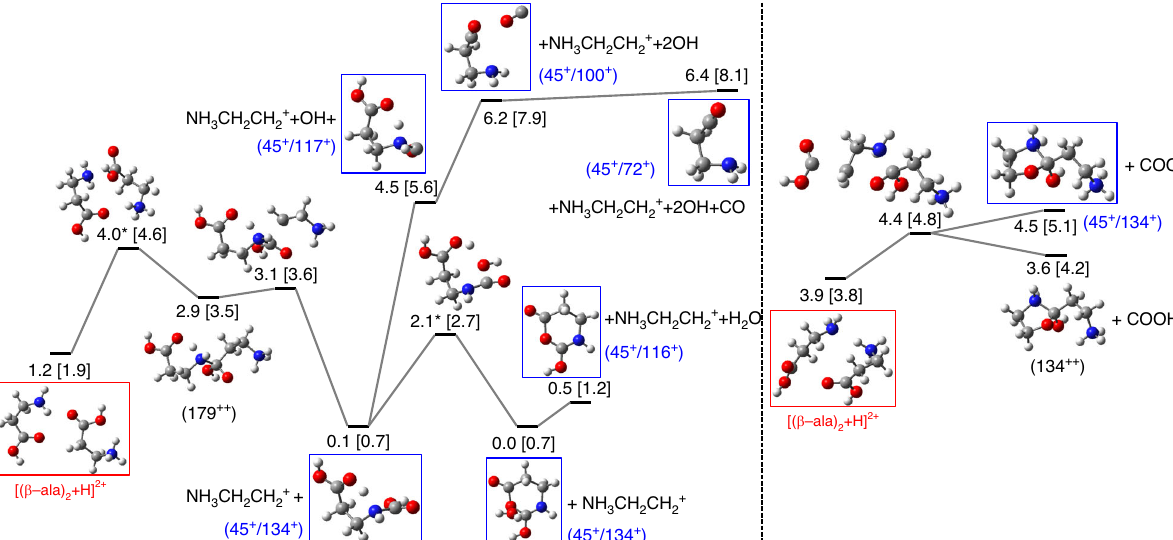
Fig. 3 Potential energy surface exploration of the doubly charged protonated dimer. Fragmentation pathways starting from the doubly charged protonated dimer ( m / z = 179/2) leading to ion pair formation, relating m / z = 45 with m / z = 134, 117, 116, 100, and 72. Red box: initial con fi guration; blue boxes: observed fragments in coincidence. Notice that the 1st vertical ionization potential for the neutral dimer is 9.7 eV and the 1st + 2nd vertical ionization potential is 27.4 eV. Geometries optimized at the DFT-M062X/6-311 ++ G(d,p) level of theory (structures with an asterisk were computed at the AM1 level). Relative energies (in eV) computed at the CCSD/6-311 ++ G(d,p) level over the geometry previously obtained and referred to the most stable neutral dimer are given next to the molecular structures. In square brackets: relative energy computed with DFT-M062X/6-311 ++ G(d,p). H atoms are given in white, C atoms in gray, N atoms in blue, and O atoms in þ H (cid:3) 2 þ in Fig. 3. The ionized dimer, see structure ½ð β (cid:2) ala Þ 2 pathways starting from this structure lie below the ionization threshold, and the corresponding reactions lead to products that are observed in the experiments. This analysis gives additional support to the idea that the ionizing collision induces intracluster proton transfer followed by the release of the excess energy through evaporation of neutral moieties.